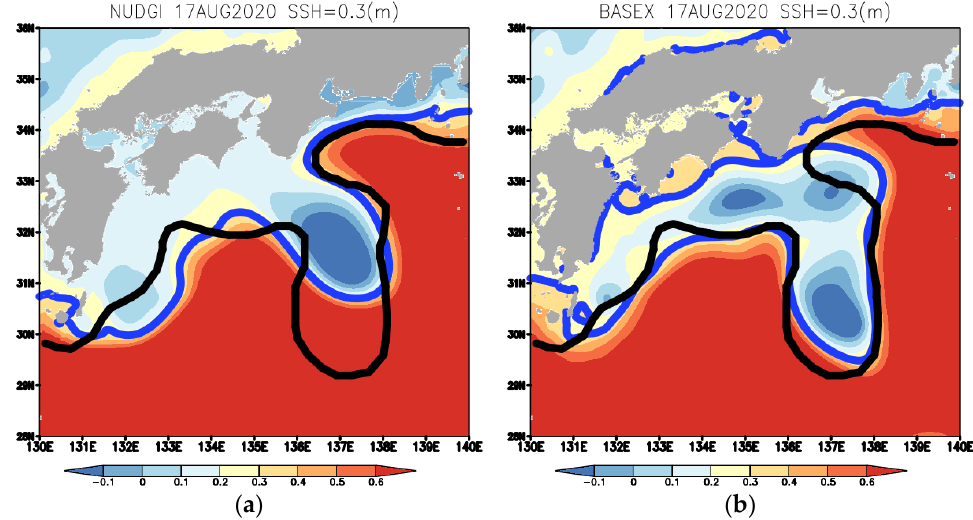
Figure 6. Daily mean modeled SSH on 17 August 2020. ( a ) NUDGI case, ( b ) BASEX case. Blue and black curves denote the locations of the modeled SSH = 0.3 m and observed Kuroshio positions, respectively.